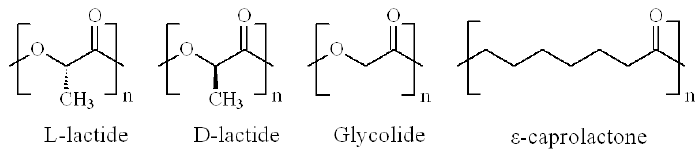
Figure 2. Chemical structure of the monomeric units of L -lactide, D -lactide, Glycolide and ε-caprolactone.